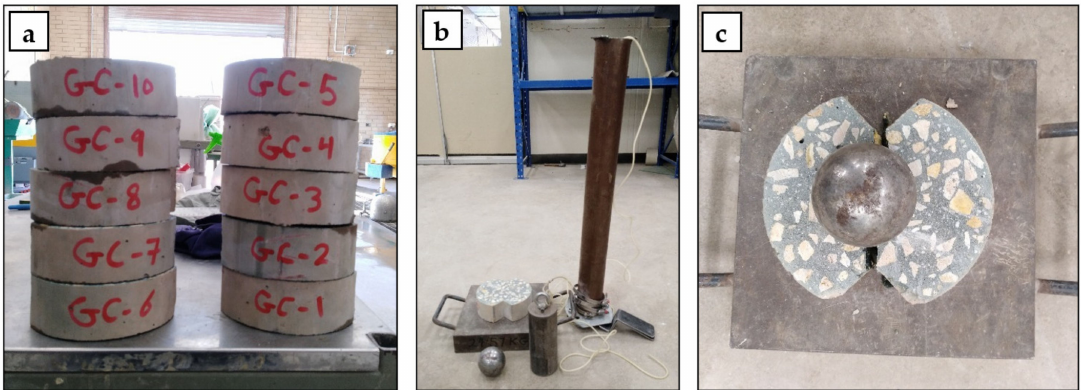
Figure 4. Impact resistance test details: ( a ) specimen preparation, ( b ) drop weight test tools, and ( c ) a tested specimen.